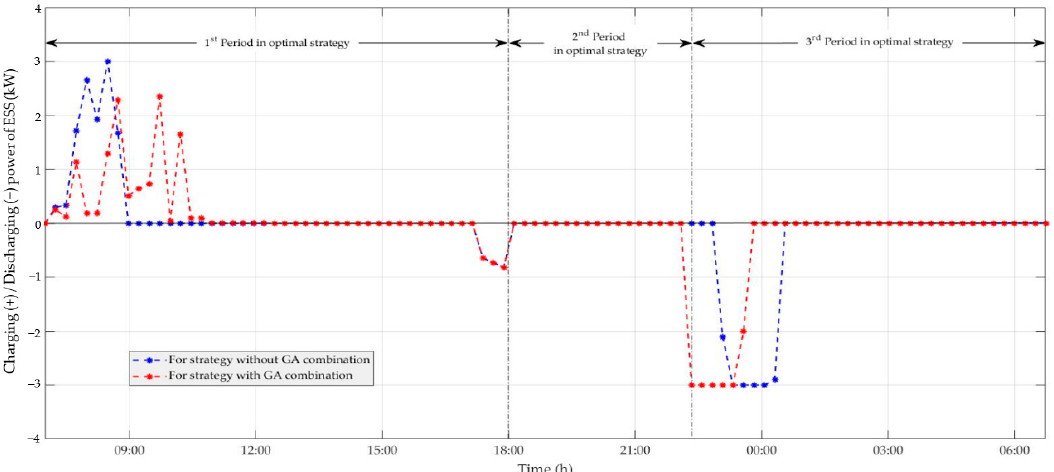
Figure 11. Comparison of charging (+)/discharging ( − ) power of the ESS using strategies with and without the GA.